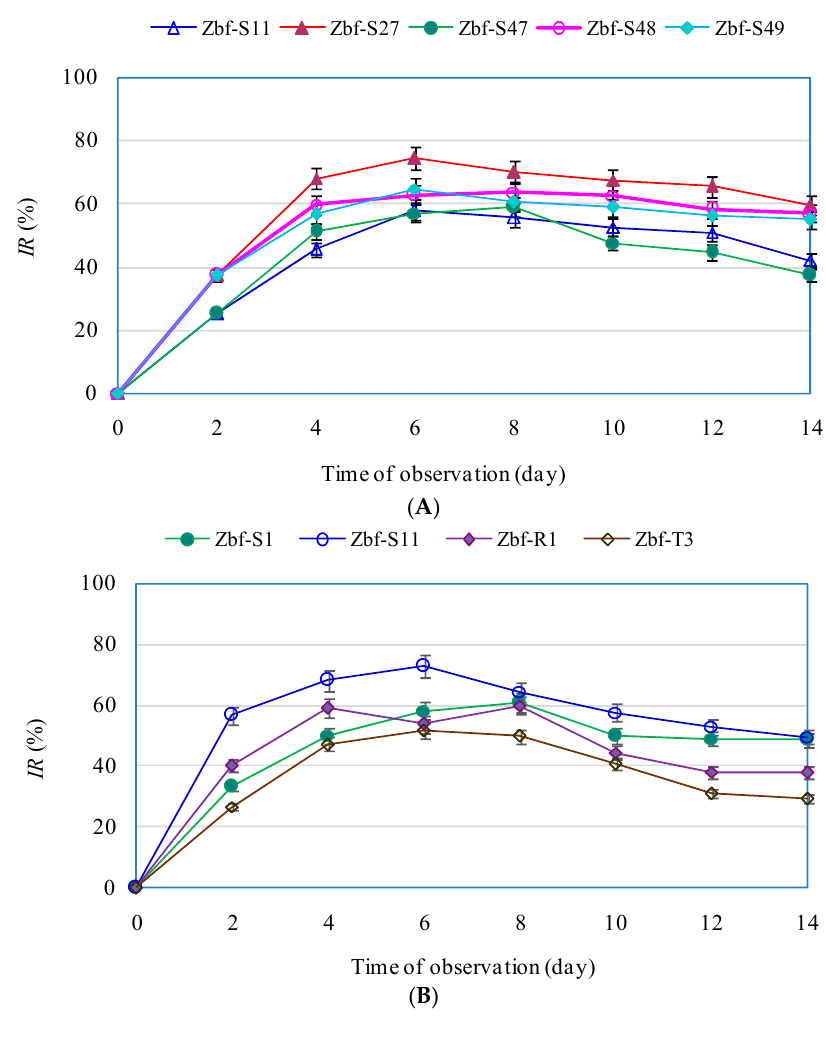
Figure 7. Time dynamics of inhibition rate for the endophytic fungal isolates with IR >50% against pathogenic fungi F. sambucinum ( A ); and P. zanthoxyli ( B ).